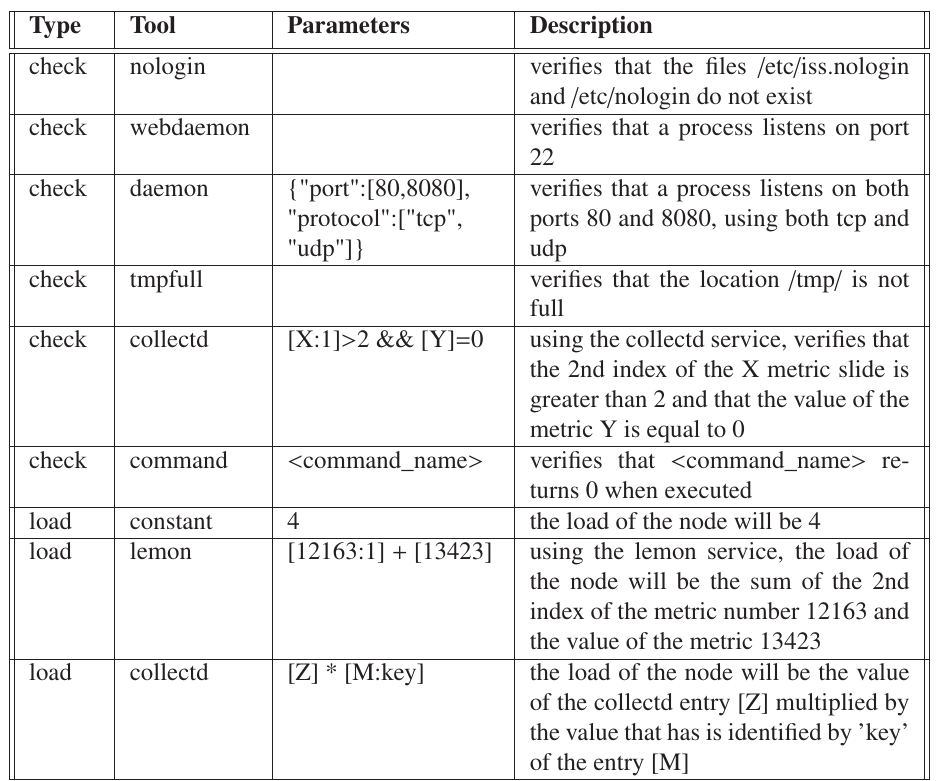
Figure 1: Components of the Load Balancing Service.